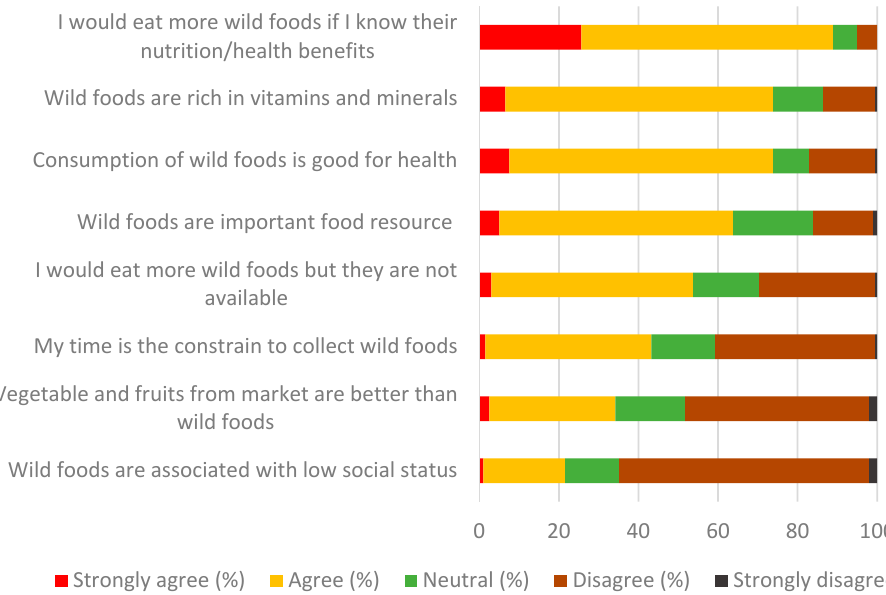
Figure 6. Attitudes of women towards consuming wild food plants.